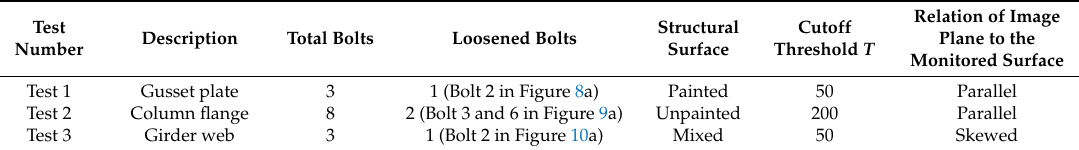
Figure 7. Tested steel joints for three experiments: ( a ) steel joints of Test 1; ( b ) steel joints of Test 2; and ( c ) steel joints of Test 3. The red blocks indicate the monitored bolts. Table 1. Test